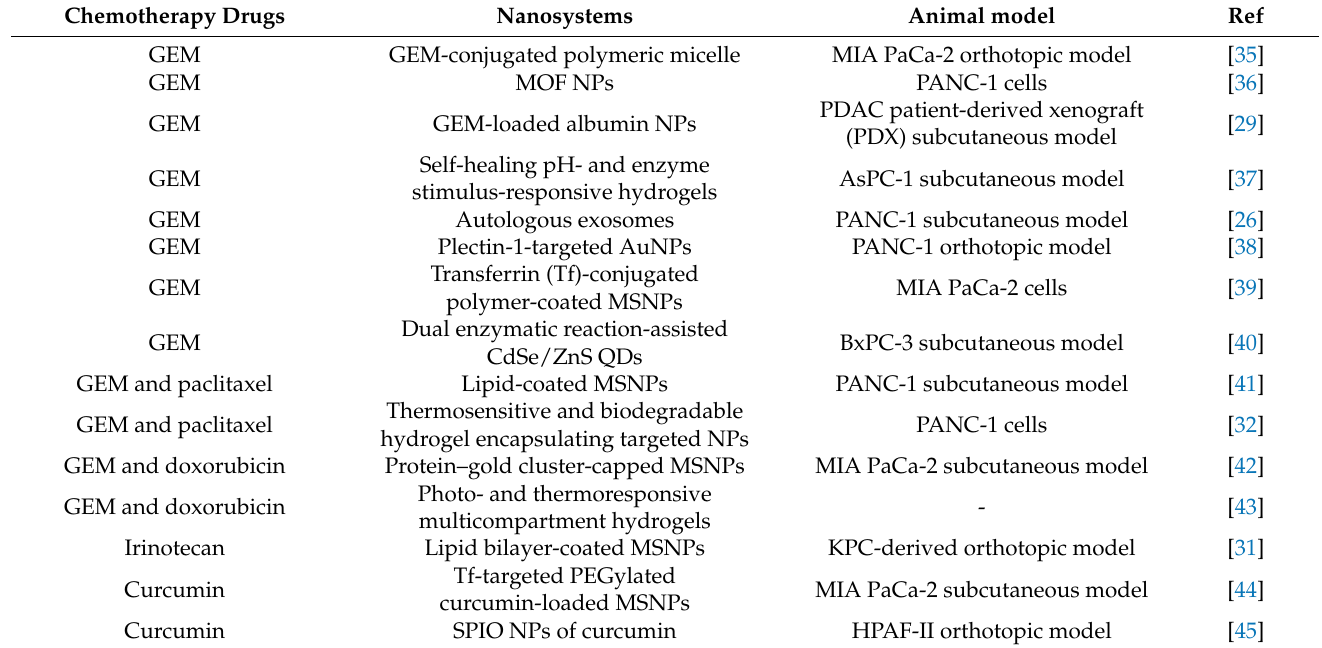
Table 2. Recent advances in chemotherapy drug delivery nanosystems for